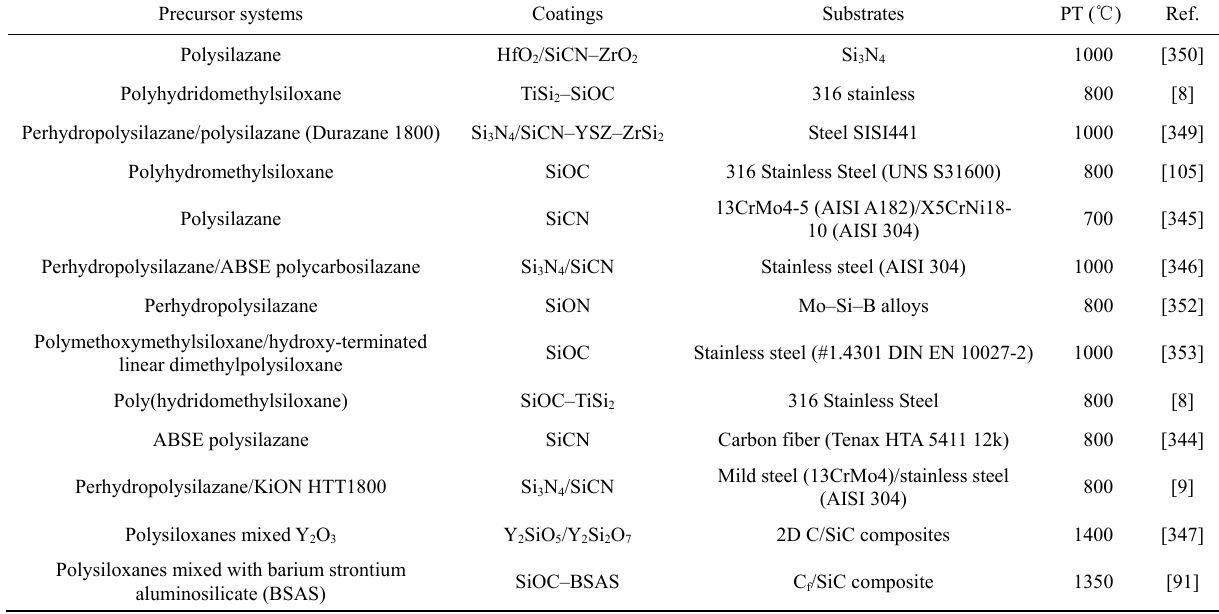
Table 3 Summary of polymer-derived TBC or EBC systems (PT = processing temperature) Precursor